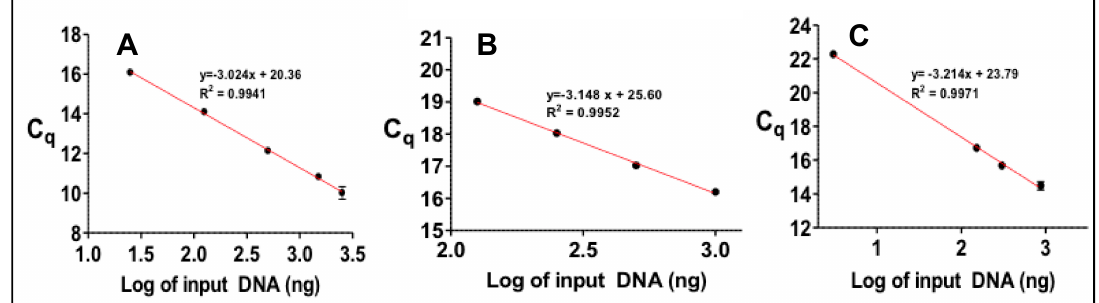
Figure A2. For the quantitation of DNA by real-time PCR a number of standards of known concentration were analyzed. The results for each gene was expressed as a function of average number of cycles (Cq) vs. known DNA concentration. Results are shown for ( A ) pks island , (B) usp and ( C ) cnf-1 .